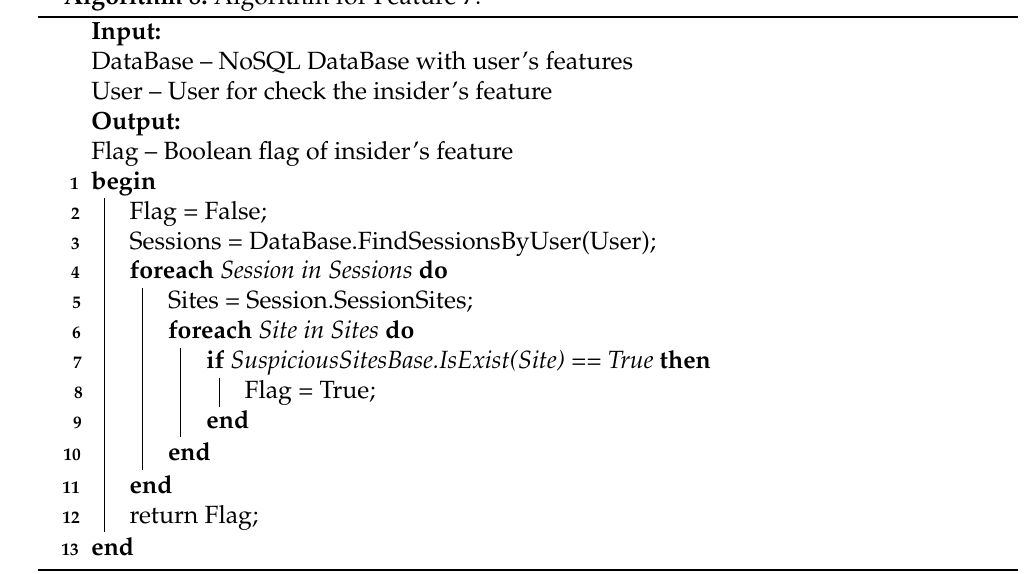
Algorithm 8: Algorithm for Feature